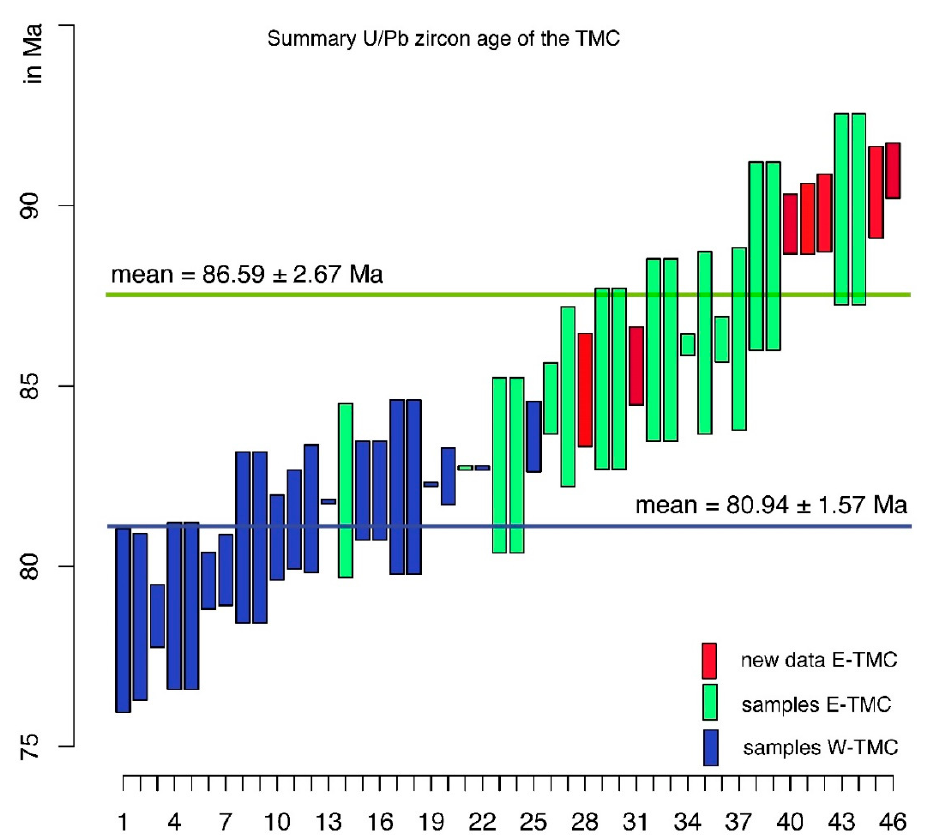
Figure 7. Summary plot of U / Pb zircon data of the TMC, including our new data set. The blue and red colours represent ages of the west- and east-TMC, respectively, whereas our new data set is plotted in red [7,11,13,32]. The individual analyses showing 2 sigma errors and new average age calculation of the East and West is 1SD error.